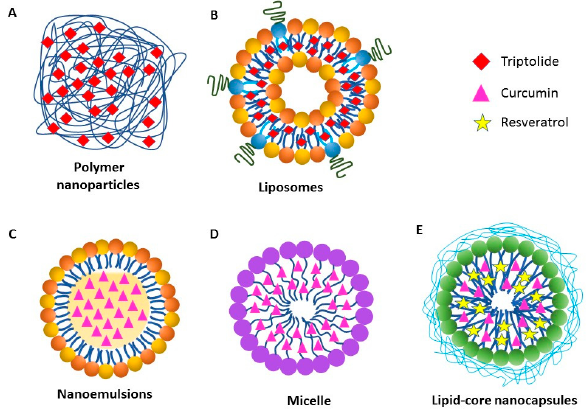
Figure 2. Schematic representation of different types of nanoparticles for the delivery of natural products. ( A ) Polymer nanoparticles encapsulating triptolide; ( B ) Liposomes loaded with triptolide; ( C ) Nanoemulsions entrapping curcumin; ( D ) Micelles encapsulating curcumin; and ( E ) Lipid core nanocapsules co-encapsulating resveratrol and curcumin.